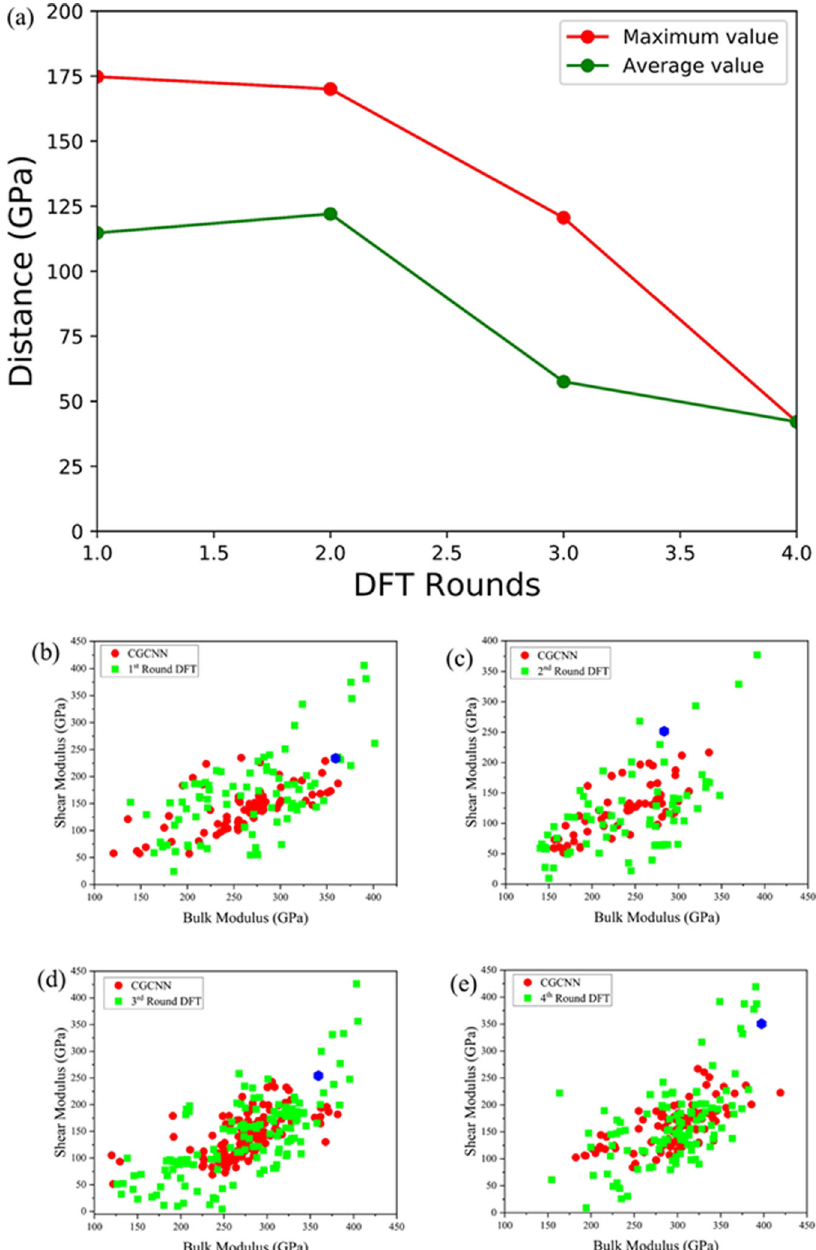
Fig. 3 Evaluation of prediction of CGCNN model for shear vs. bulk modulus. a Maximum and average distance between outlier of CGCNN prediction and DFT calculation for bulk and shear moduli. For each round we measure the distance between the outlier of CGCNN prediction (blue symbols in bottom panels) and all DFT values with bulk and shear moduli higher than CGCNN prediction. b – e Comparison between CGCNN prediction and DFT values for the 1st, 2nd, 3rd, and 4th round, respectively. The blue symbol denotes the outlier structure from CGCNN prediction that is used for calculating the distances to real DFT